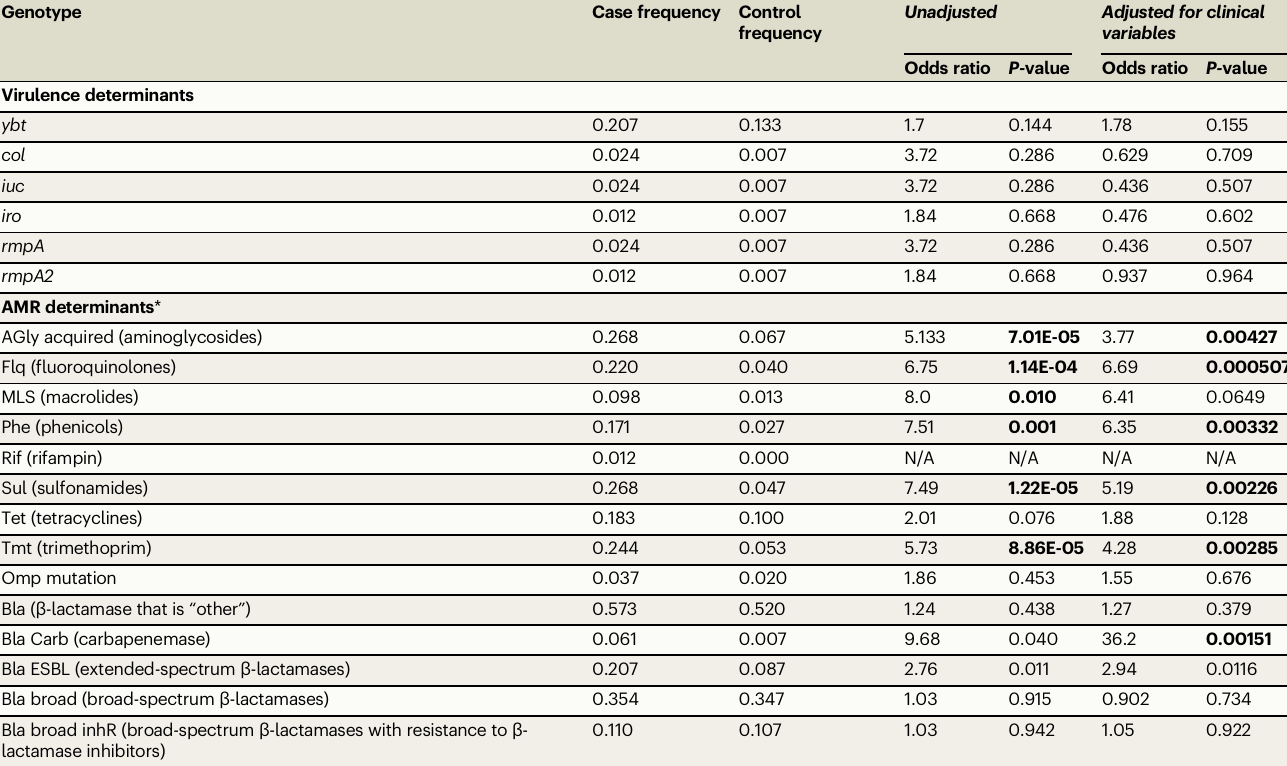
Table 3 | Klebsiella genotype association with infection